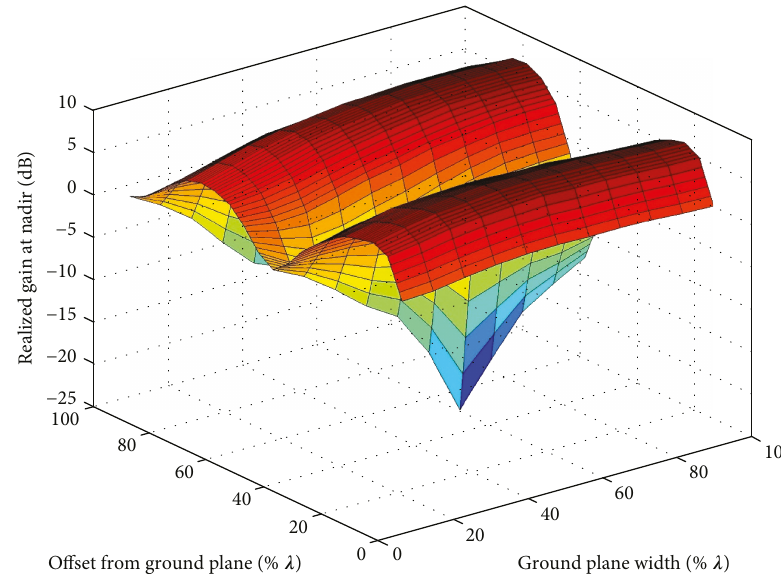
Figure 18: 3D plot showing gain relationship to ground plane width and o ff set.